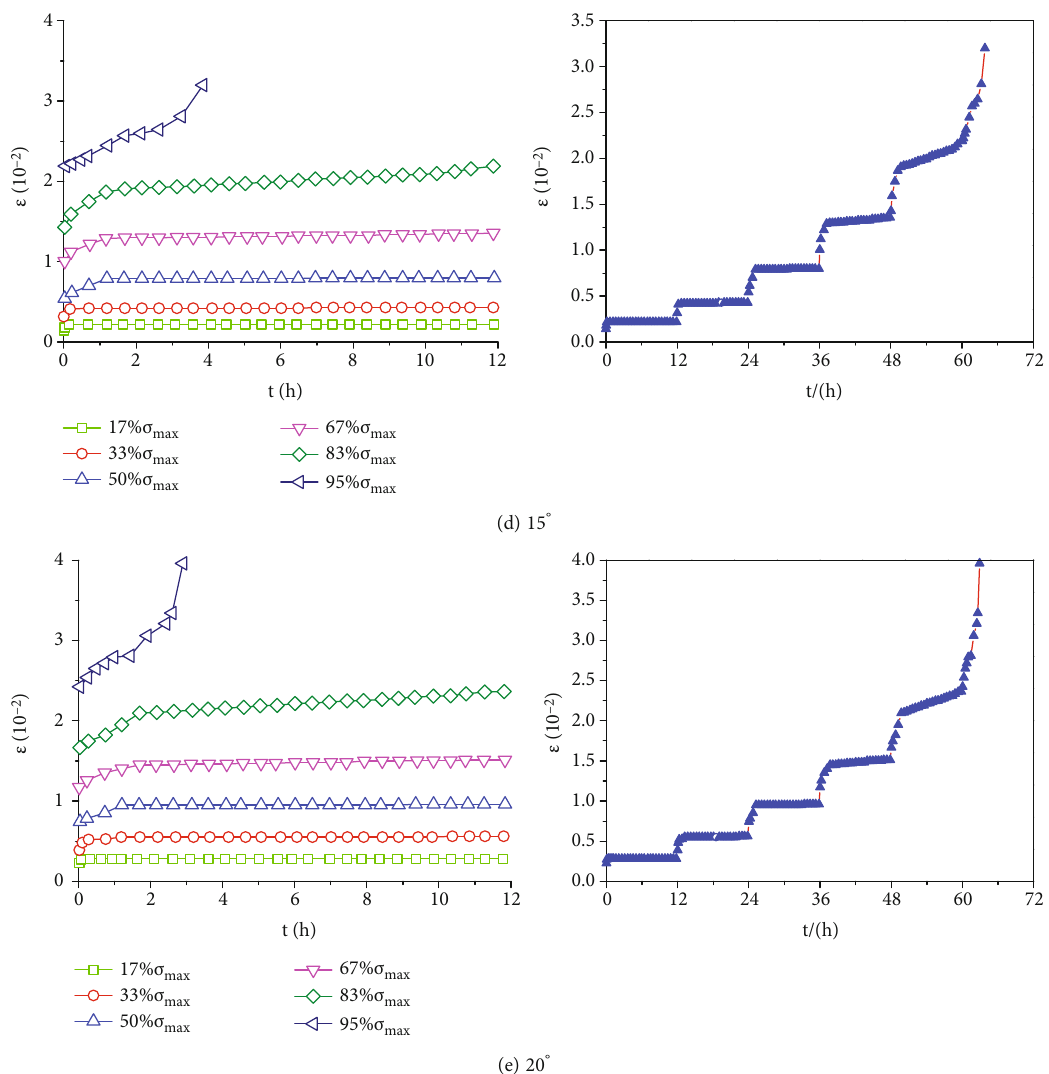
Figure 8: Axial strain-time creep curve of coal specimens under various inclination